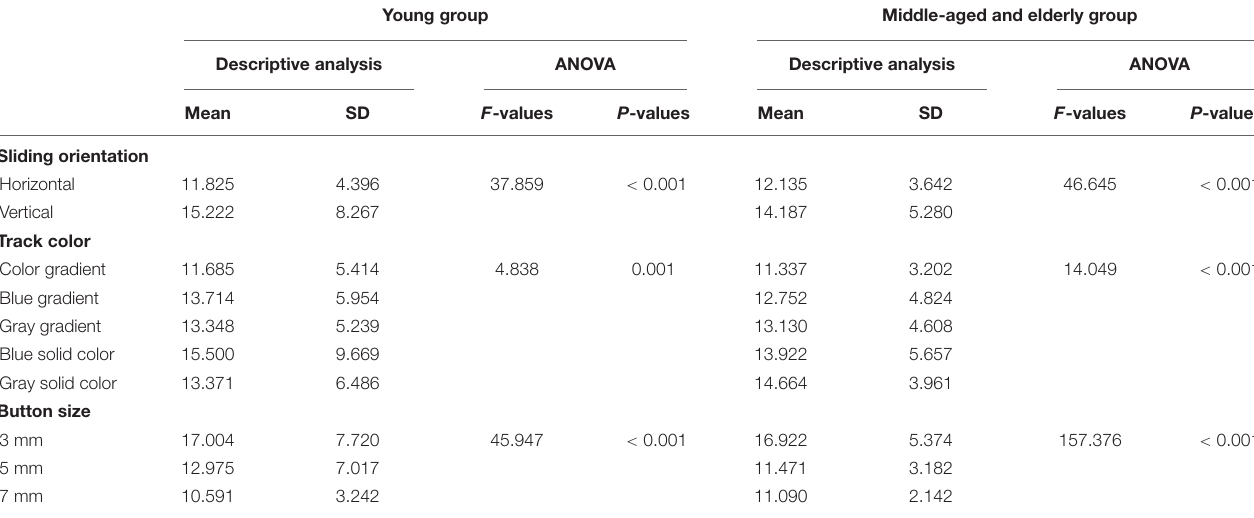
TABLE 4 | Main effects of sliding orientation, track color, and button size on number of saccades (times).